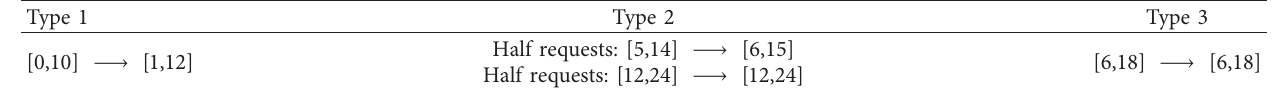
Table 4: Time window settings of base instances (pick-up ⟶ delivery,